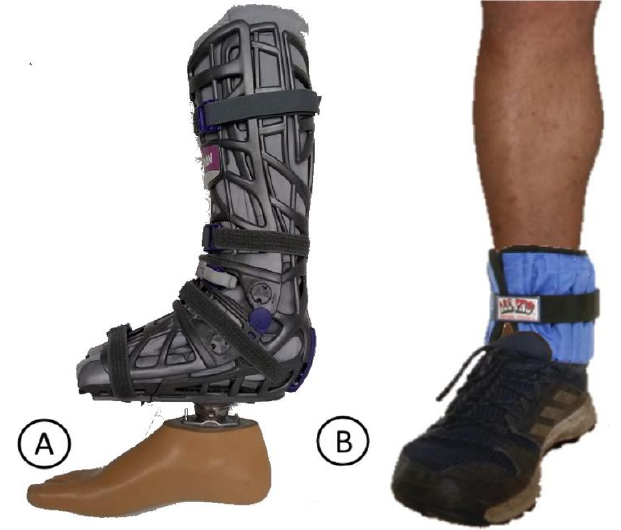
Figure 3. ( A ) Leg extension device increasing the length of the trailing leg by 15 cm. ( B ) Cuff weight increasing the weight of the trailing leg by 4.5 kg.